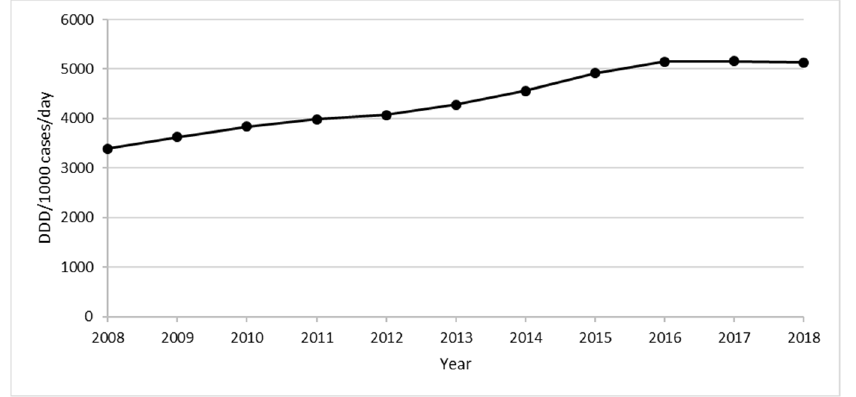
Figure 6. Consumption of all drugs in the period 2008–2018.